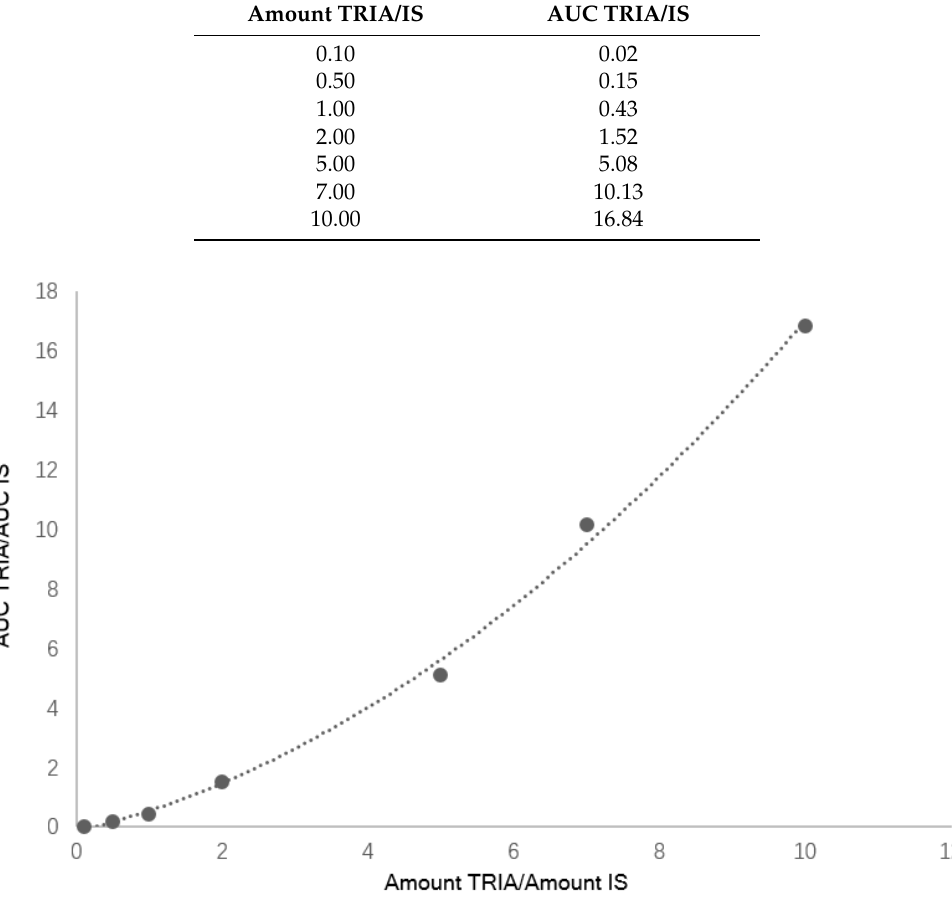
Figure 1. Calibration curve for TRIA.